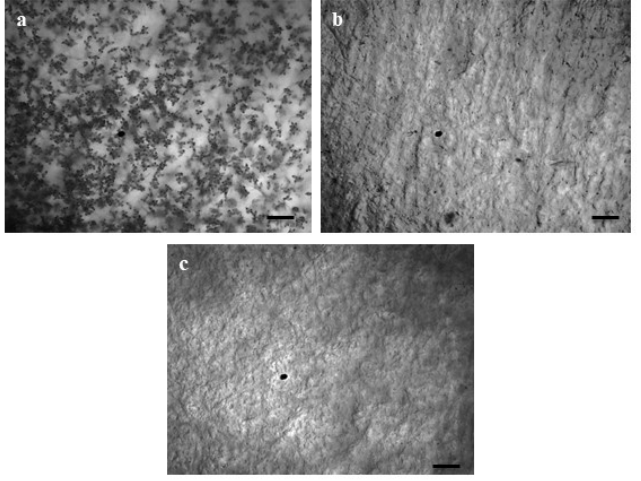
Figure 4. Effects of antimycin A and the commercial fungicide Nativo ® 75 WG on the suppression of conidiogenesis of MoT in Nunc multidisc at 10 µg/mL. ( a ) Control, ( b ) antimycin A, ( c ) Nativo ® of conidiogenesis of MoT in Nunc multidisc at 10 µ g/mL. ( a ) Control, ( b ) antimycin A, ( c ) Nativo ® 75 WG. Bar = 50 µm. 75 WG. Bar = 50 µ